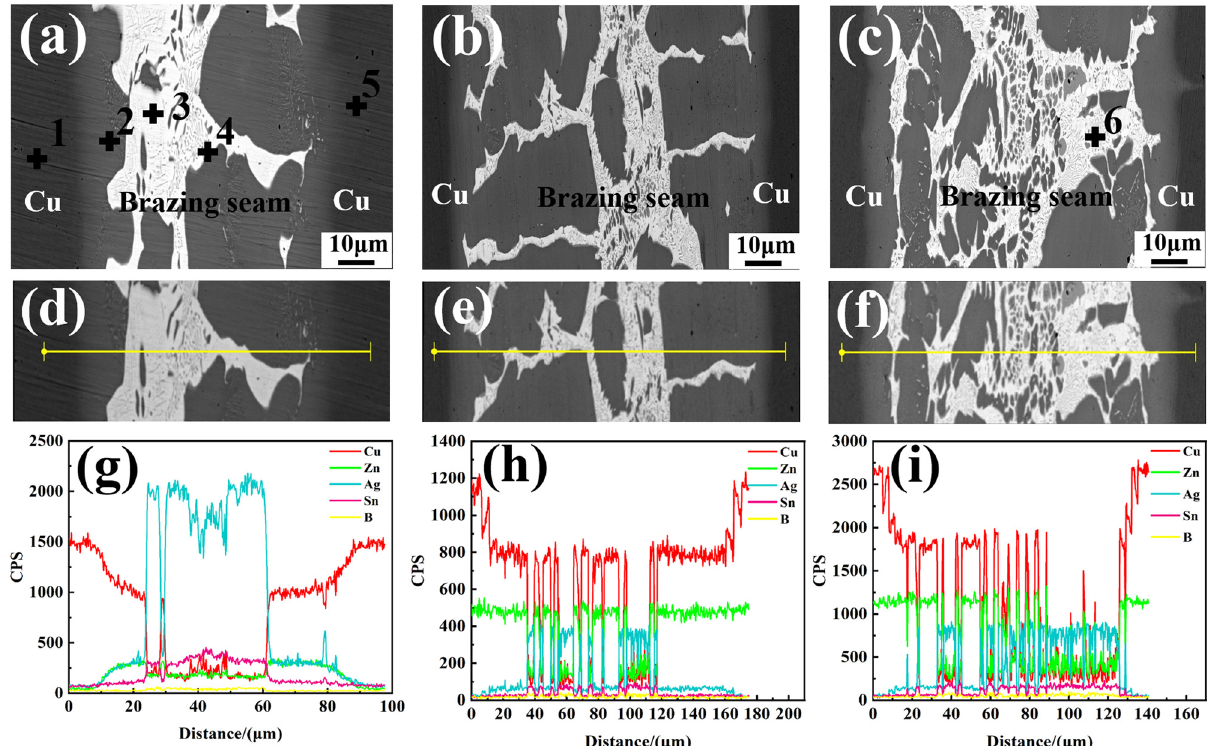
Figure 3: SEM images of ( a ) 0%, ( b ) 2%, and ( c ) 3% brazed joints. ( d, e, and f ) 0, 2, and 3% brazed joint line scanning positions and ( g, h, and i ) 0, 2, and 3% line scan